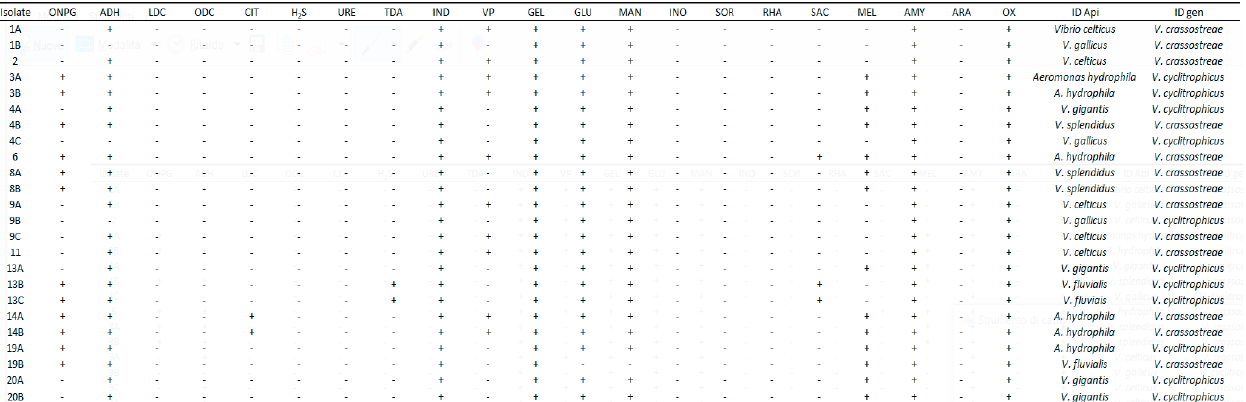
Figure 2. Biochemical features of isolates (API ® 20E). ONPG: test for β -galactosidase enzyme by hydrolysis of the substrate o-nitrophenyl-b-D-galactopyranoside; ADH, decarboxylation of the amino acid arginine by arginine dihydrolase; LDC, decarboxylation of the amino acid lysine by lysine decarboxylase; ODC, decarboxylation of the amino acid ornithine by ornithine decarboxylase; CIT, utilization of citrate as only carbon source; H 2 S, production of hydrogen sulfide; URE, test for the enzyme urease; TDA, tryptophan deaminase; detection of the enzyme tryptophan deaminase: reagent, ferric chloride; IND: indole test production of indole from tryptophan by the enzyme tryptophanase. Reagent–indole is detected by addition of Kovac’s reagent; VP, the Voges–Proskauer test for the detection of acetoin (acetyl methylcarbinol) produced by fermentation of glucose by bacteria utilizing the butylene glycol pathway; GEL, test for the production of the enzyme gelatinase, which liquefies gelatin; GLU, fermentation of glucose (hexose sugar); MAN, fermentation of mannose (hexose sugar); INO, fermentation of inositol (cyclic polyalcohol); SOR, fermentation of sorbitol (alcohol sugar); RHA, fermentation of rhamnose (methyl pentose sugar); SAC, fermentation of sucrose (disaccharide); MEL, fermentation of melibiose (disaccharide); AMY, fermentation of amygdalin (glycoside); ARA, fermentation of arabinose (pentose sugar). In the last two columns, there is the API identifier and the real identifier provided by the molecular analysis.